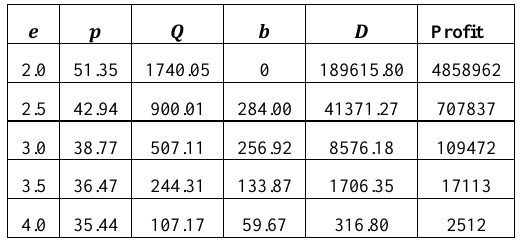
Table 4. Effect of changing price elasticity index on the selling price, optimal order level, backorder level, and retailer’s expected